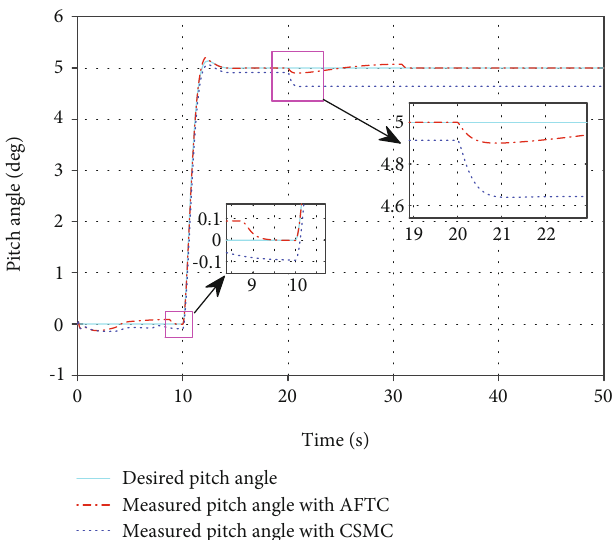
Figure 3: Pitch motion tracking performance of the UAV in the presence of elevator fault in scenario 1.